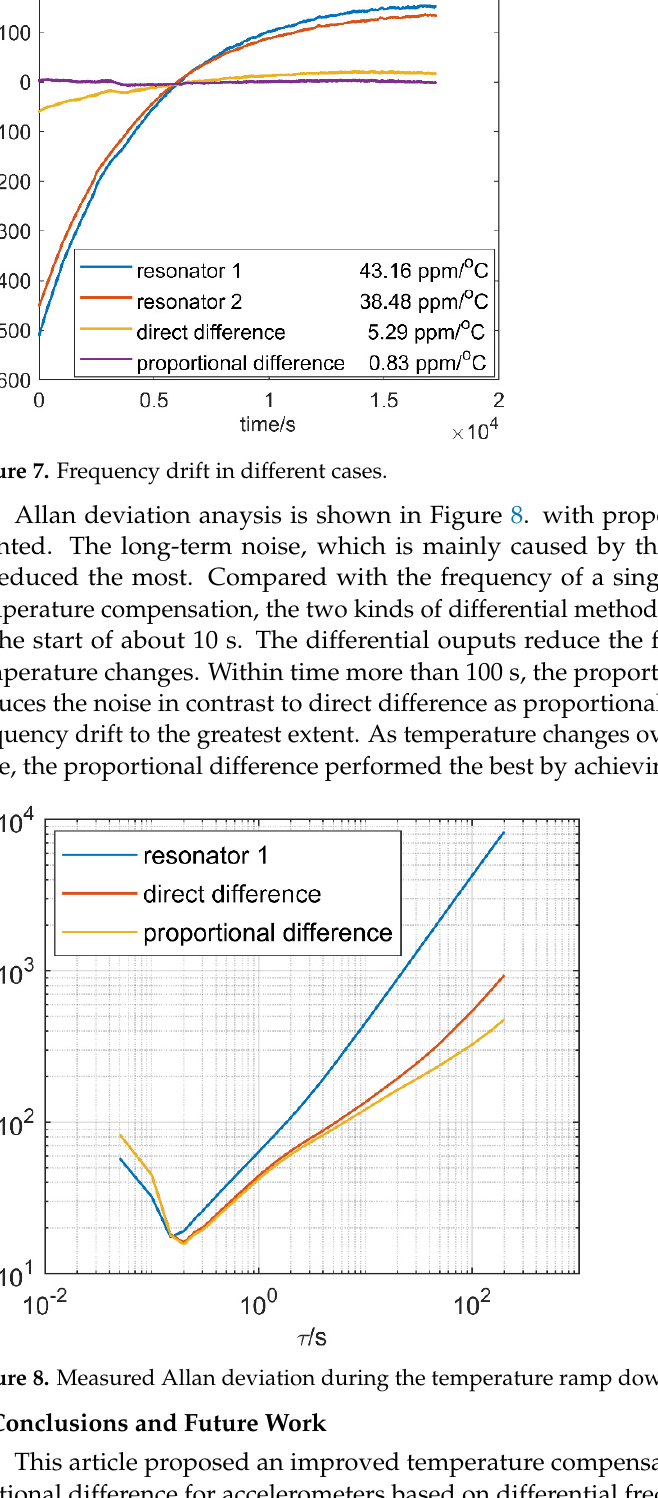
Figure 8. Measured Allan deviation during the temperature ramp down.